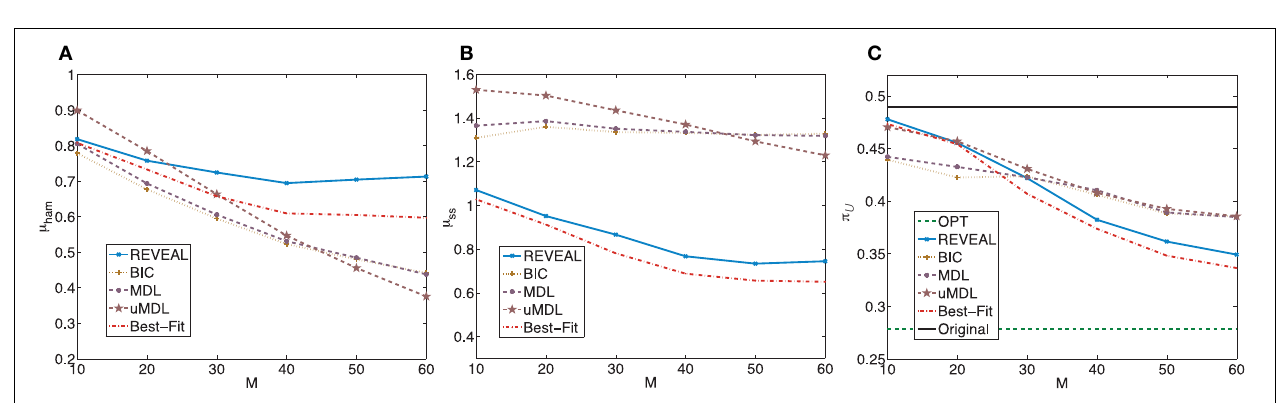
stationary control policies based on inferred networks to the original ground truth BNps, compared to the average undesirable mass obtained by the optimal control policy (OPT) based on the complete knowledge of original BNps and the average undesirable mass before intervention (Original).